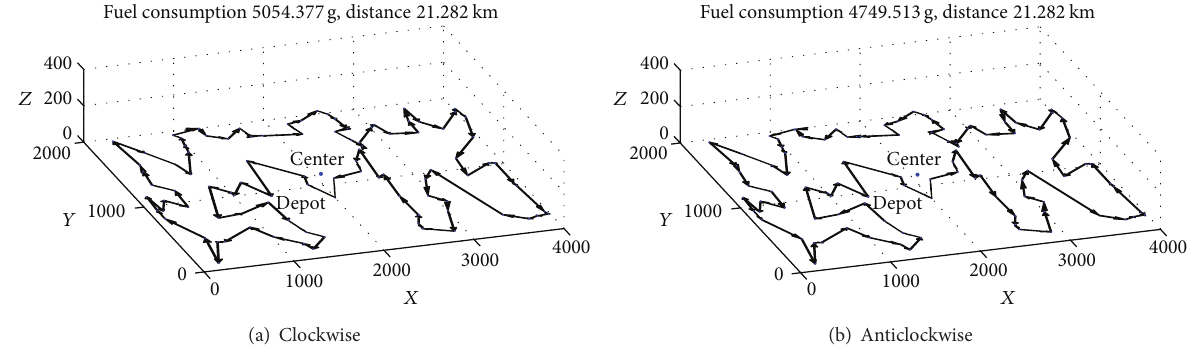
Figure 5: The comparison of fuel consumption of driving clockwise and anticlockwise.